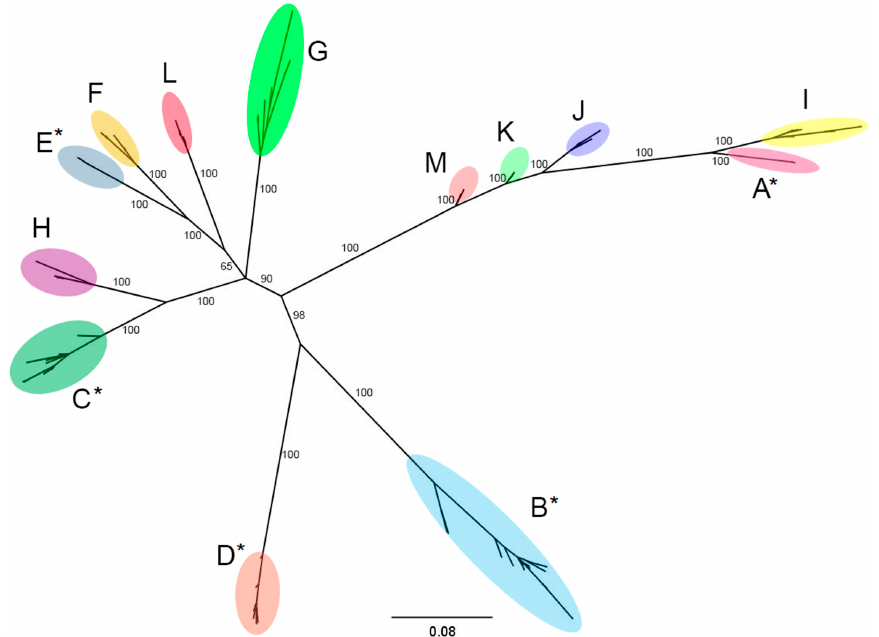
Figure 1. Phylogenetic analysis. The full coding region of 106 mytimycin sequences obtained from 16 genomes were subjected to multiple sequence alignment and analyzed with Bayesian phylogenetic inference. The employed evolution model was the Hasegawa, Kishino, and Yano 1985 model (HKY + G). Thirteen clusters of sequences are defined with high posterior probability support. * indicates previously described isoforms.